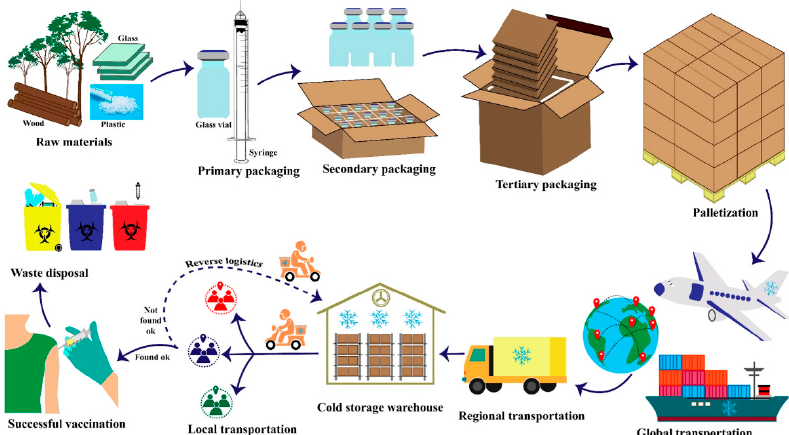
Figure 3. The coronavirus disease vaccine is packaged and distributed in various levels to ensure cold storage throughout the supply chain for a successful vaccination campaign (taken from) [190].